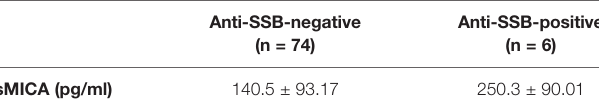
TABLE 3 | Increased circulating sMICA concentrations in SLE patients positive for anti-SSB